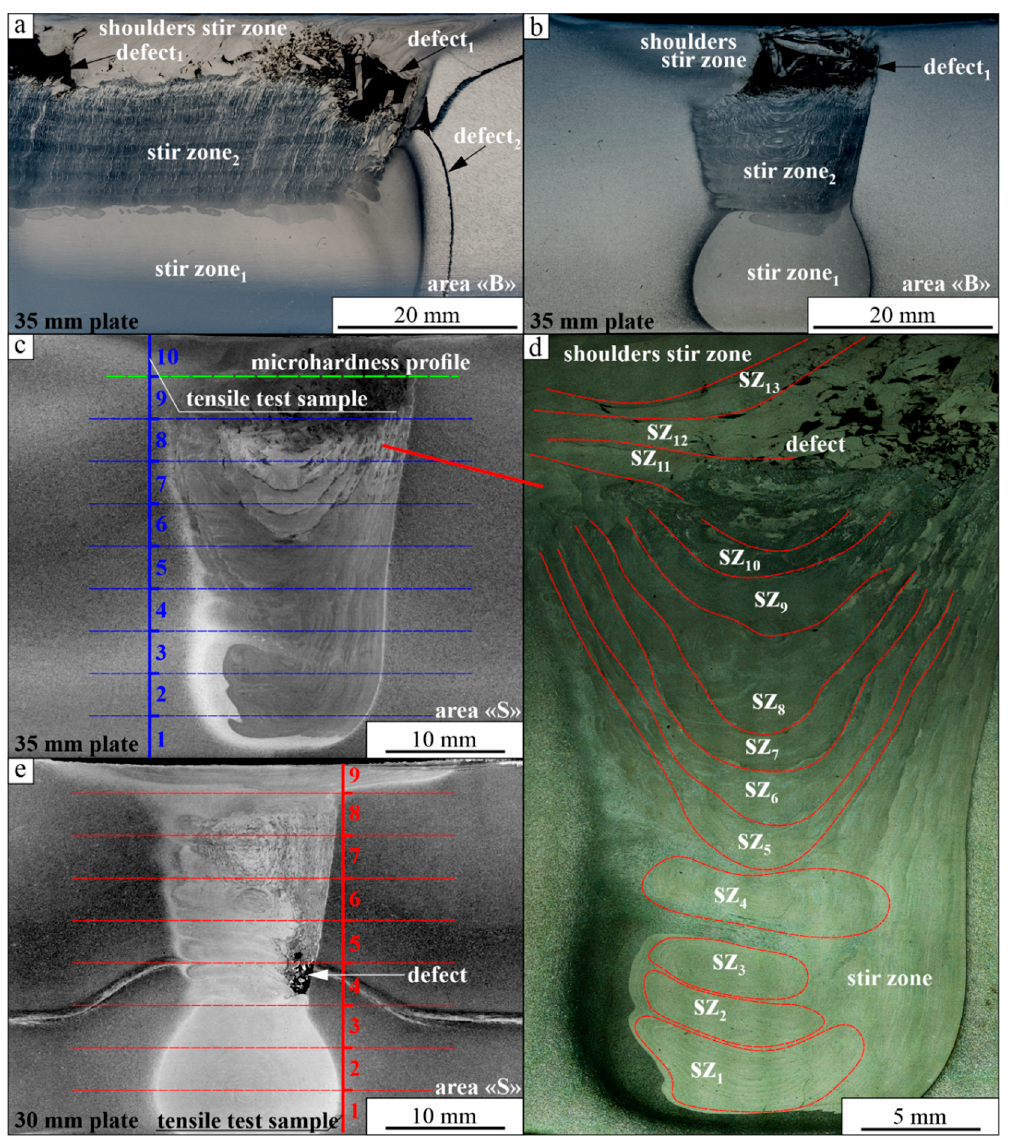
Figure 3. The macrostructures of the FSW joint on 35 mm thickness alloy sheet in section parallel to the joint line: ( a ) the cross section of zone B ( b ); the cross section of zone S ( c ); the multi-nugget macrostructure of the stir zone ( d ); and a cross section view of the joint on the 30 mm thickness metal ( e ).